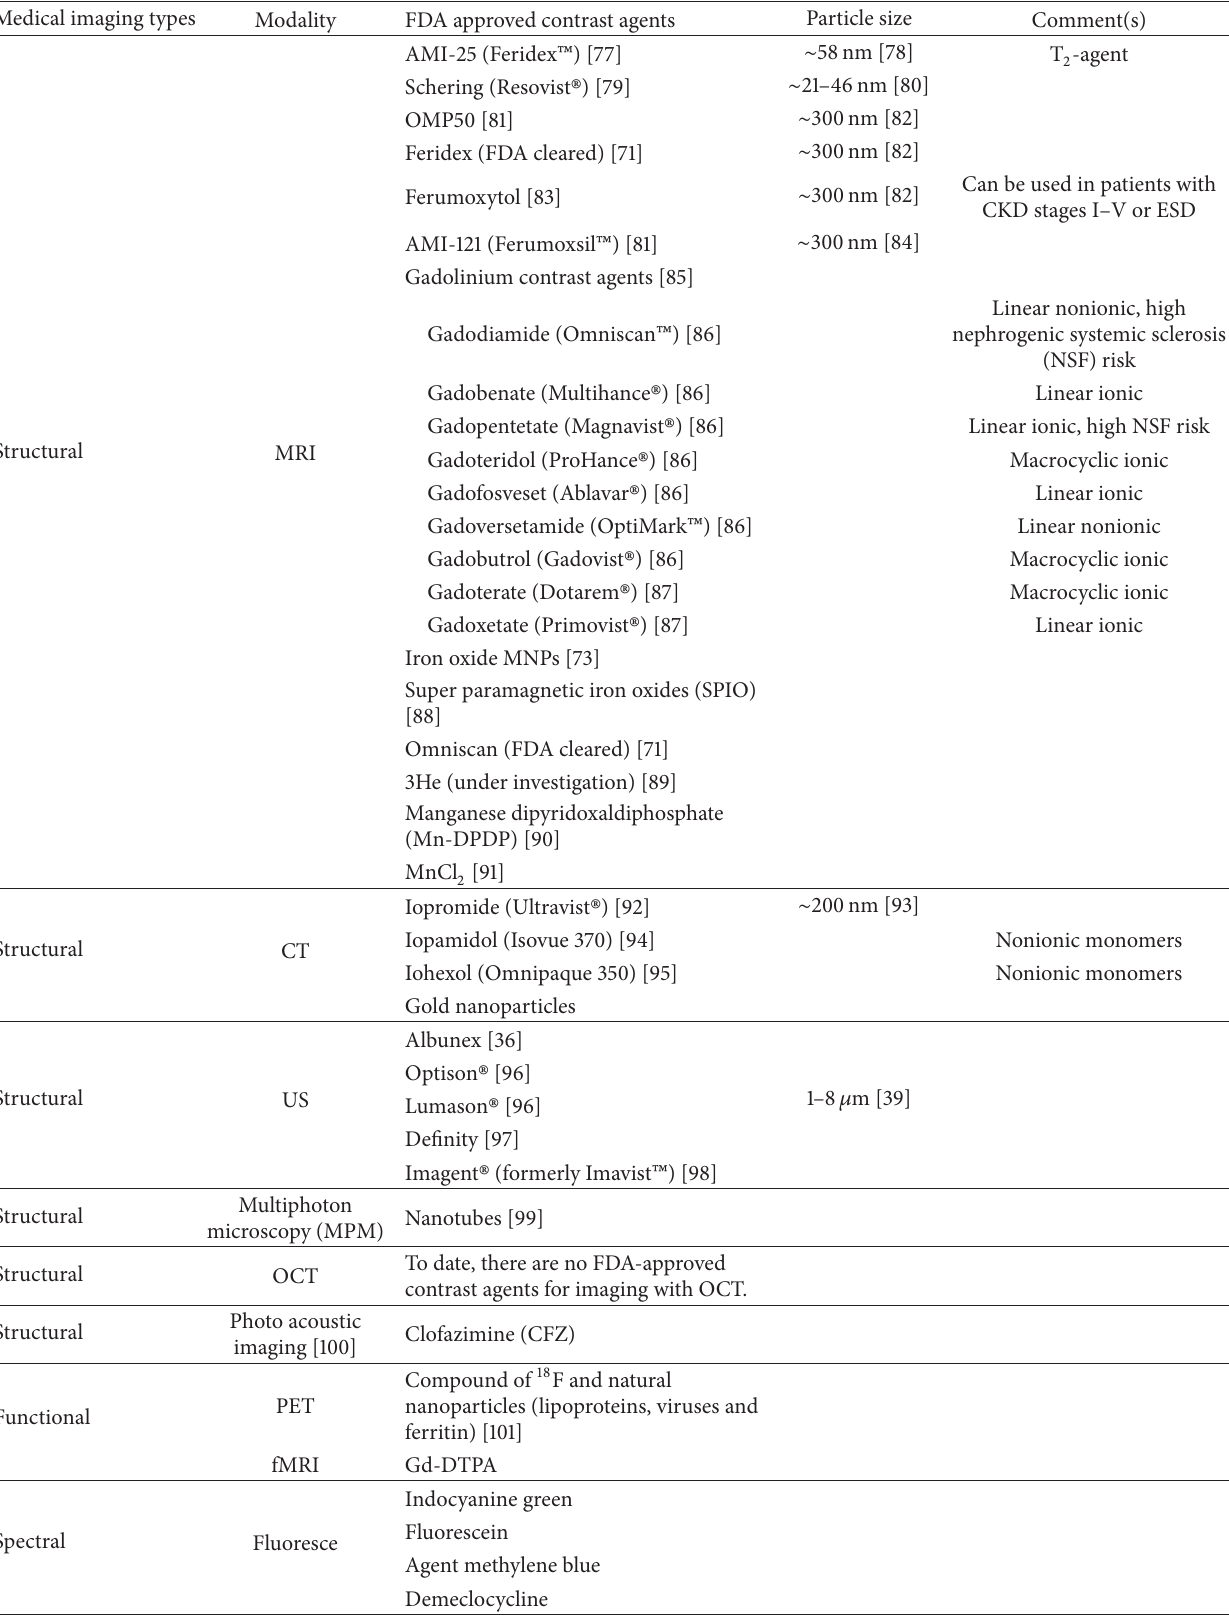
Table 3: Different contrast